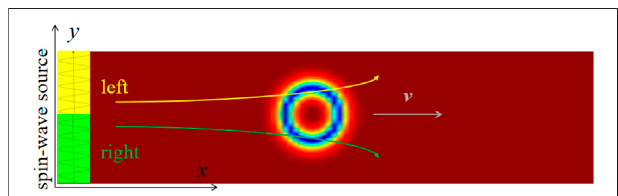
FIGURE 1 | The model of AFM skyrmion driven by double circularly polarized spin waves. The yellow and green regions represent the source of left-handed and right-handed circularly polarized spin waves, respectively. The yellow and green arrows indicate the scattering direction of the spin waves, and the gray arrow indicates the driving direction of the